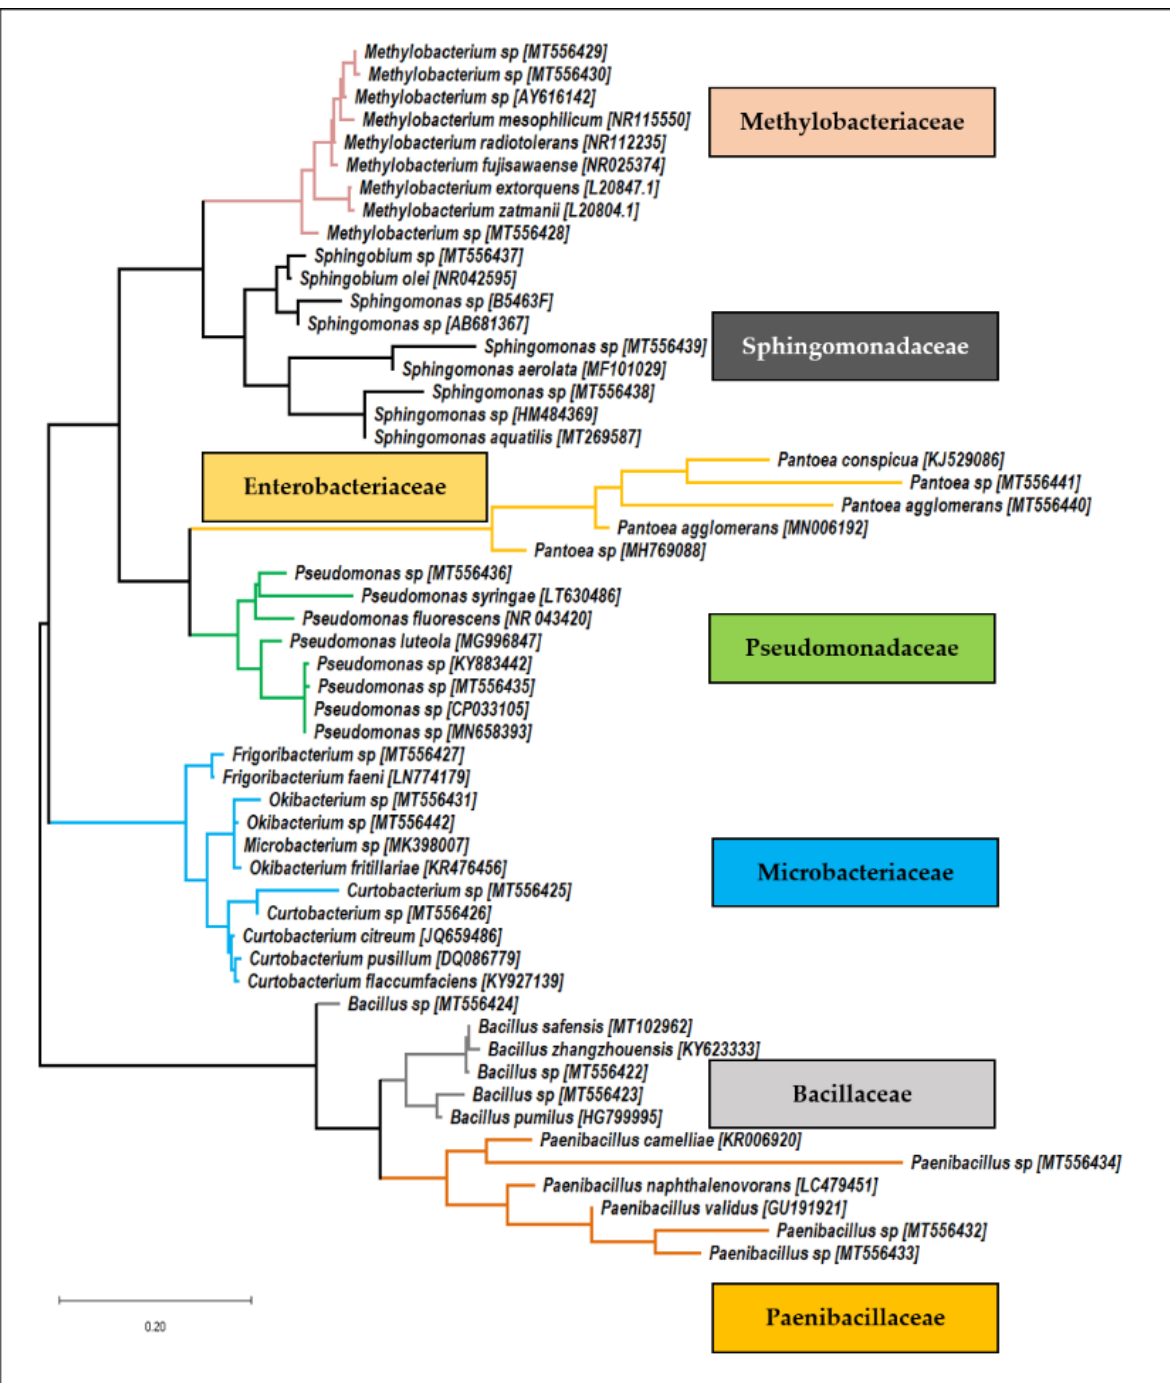
Figure 2. Phylogenetic tree constructed by Maximum Likelihood method and based on 16S rDNA gene analysis of the most frequently identified culturable bacterial endophytes from olive sapwood, in reference to closest type strains obtained from the Ribosomal Database in NCBI. The accession numbers (MT556422-MT55639, MT973971) (supplementary file 7) refer to our annexed bacterial sequences in NCBI.